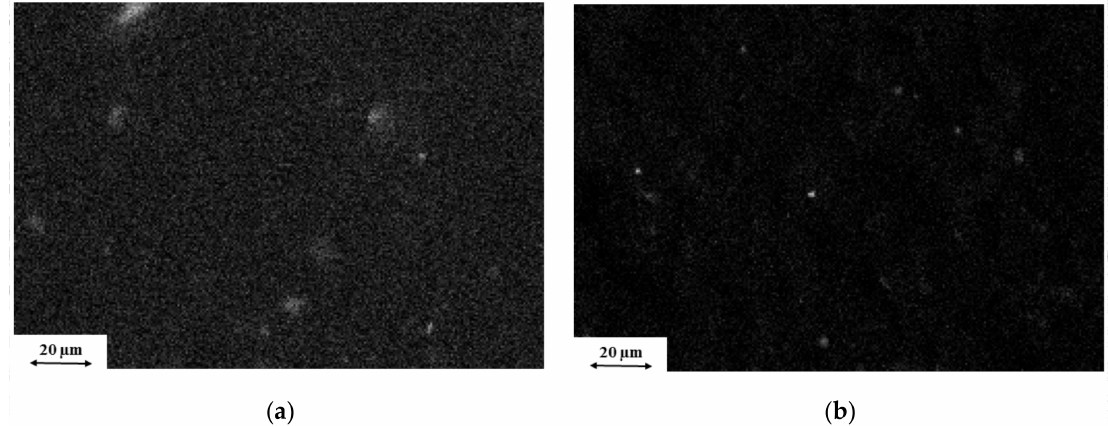
Figure 3. EDS images of fracture surfaces (white dots mark silicon elements) of ( a ) 97% rPET + 3% MMT and ( b ) 97% rPET + 3% oMMT.